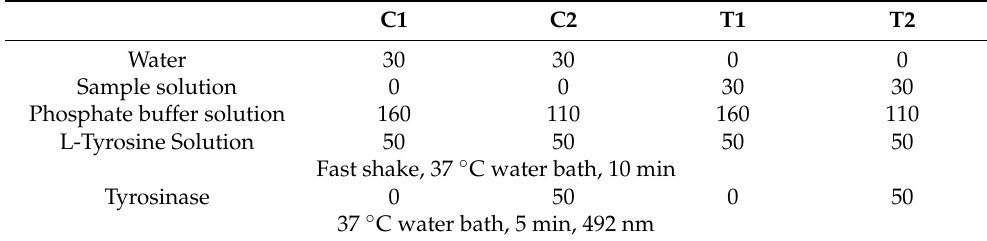
Table 2. Composition of the reaction solution ( µ